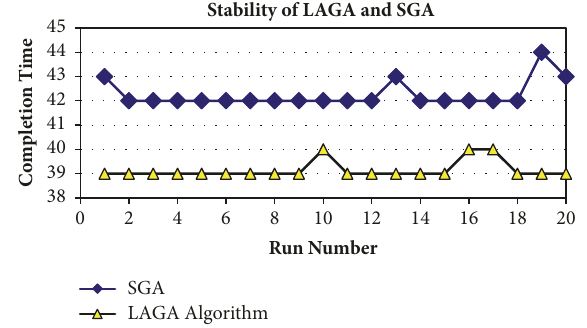
Figure 7: Comparison of the stability proposed algorithm and standard genetic algorithm.